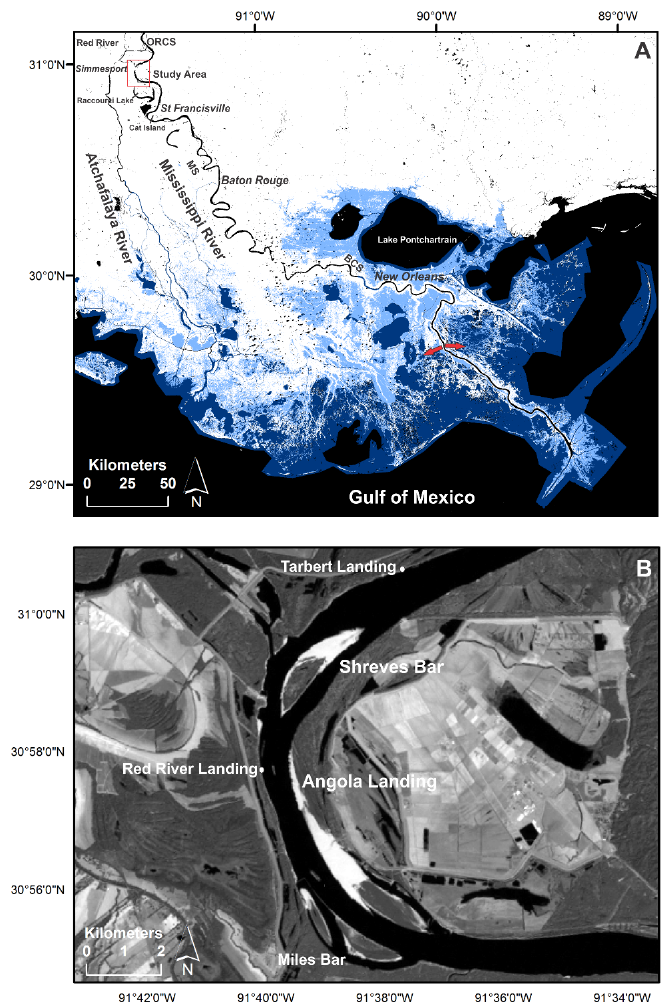
Figure1. ( A ) Map of southeastern Louisiana, with the locations of Old River Control Structure (ORCS), Morganza Spillway (MS), Bonnet Carré Spillway (BCS), cities, and proposed sediment diversions (red arrows). Blue area is the potential sinking area for the period up to 2050 based upon the elevation and sea level trend data from the U.S. Geological Survey and National Oceanic and Atmospheric Administration [29]; ( B ) The locations of Shreves Bar, Angola Landing and Miles Bar, Tarbert Landing (TBL) and Red River Landing